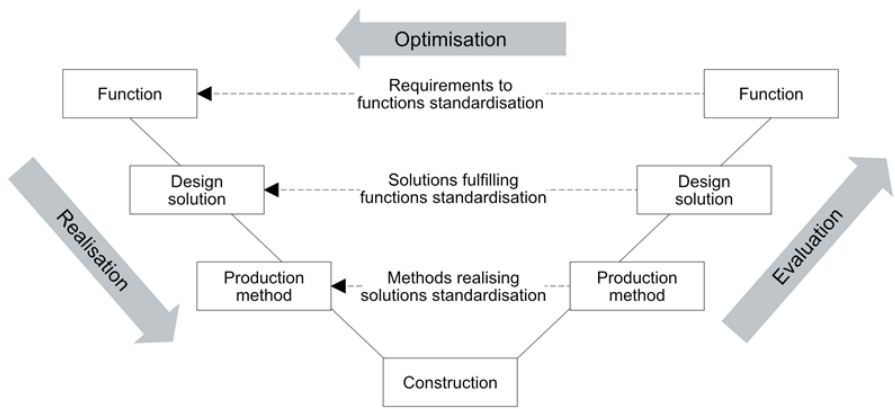
Figure 1. The use of configuration information to improve realisation, evaluation and optimisa- tion.